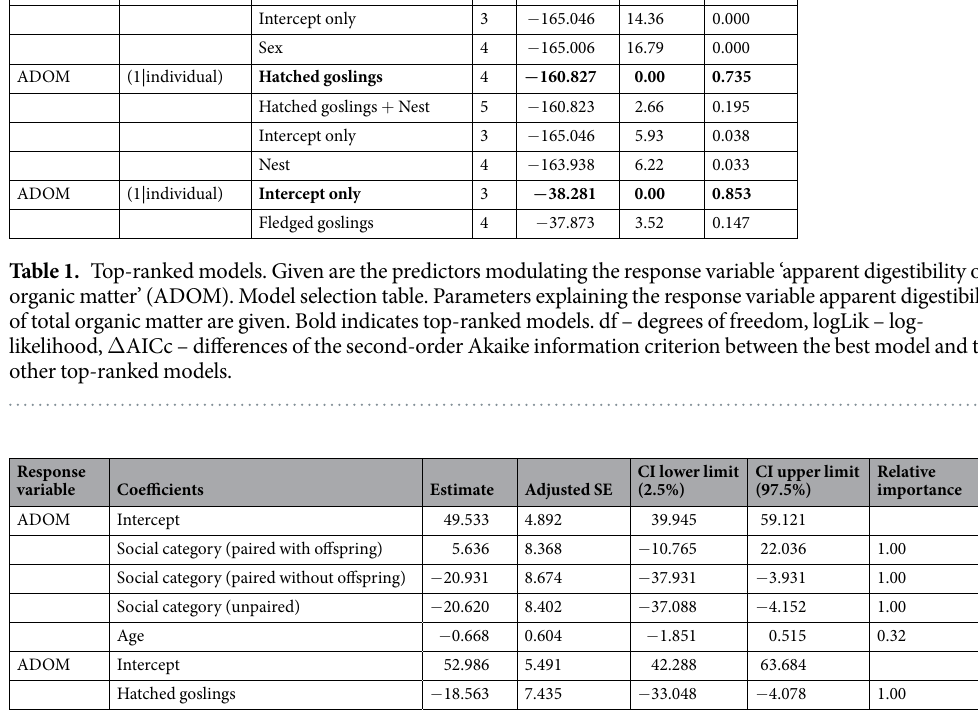
Table 2. Model-averaged coefficients. Given are the coefficients with adjusted standard errors, lower and upper confidence intervals and relative importance of the top-ranked models. Model-averaged coefficients of the top- ranked models including adjusted standard errors (SE), lower and upper confidence intervals (CI) and relative importance. For social category, juveniles were set to